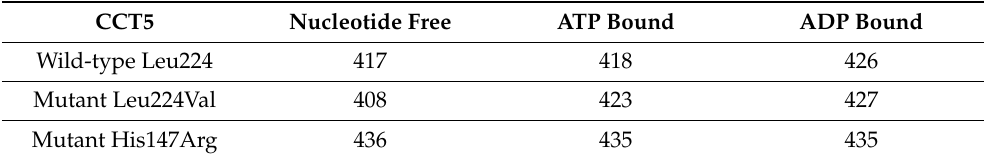
Table 1. Number of hydrogen bonds in CCT5 wild type and its two mutants under three conditions: nucleotide-free, ATP-bound, and ADP-bound.